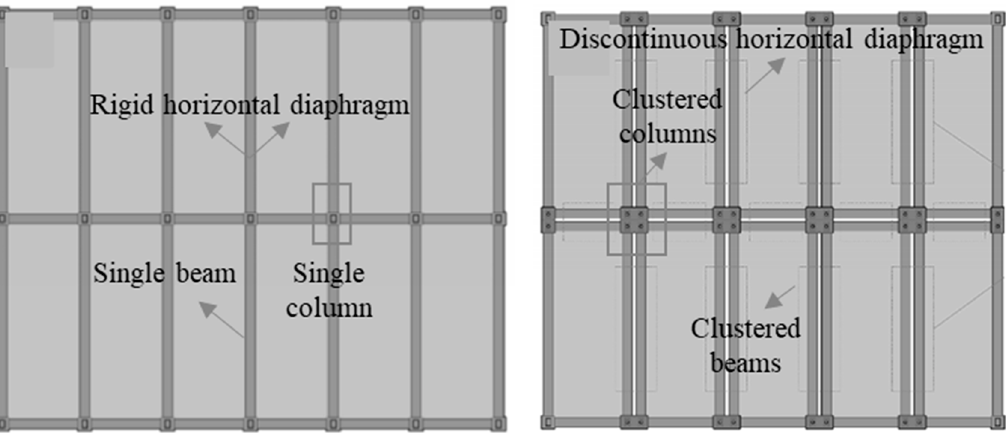
Figure 12. Cluster columns, beams, and discontinuous